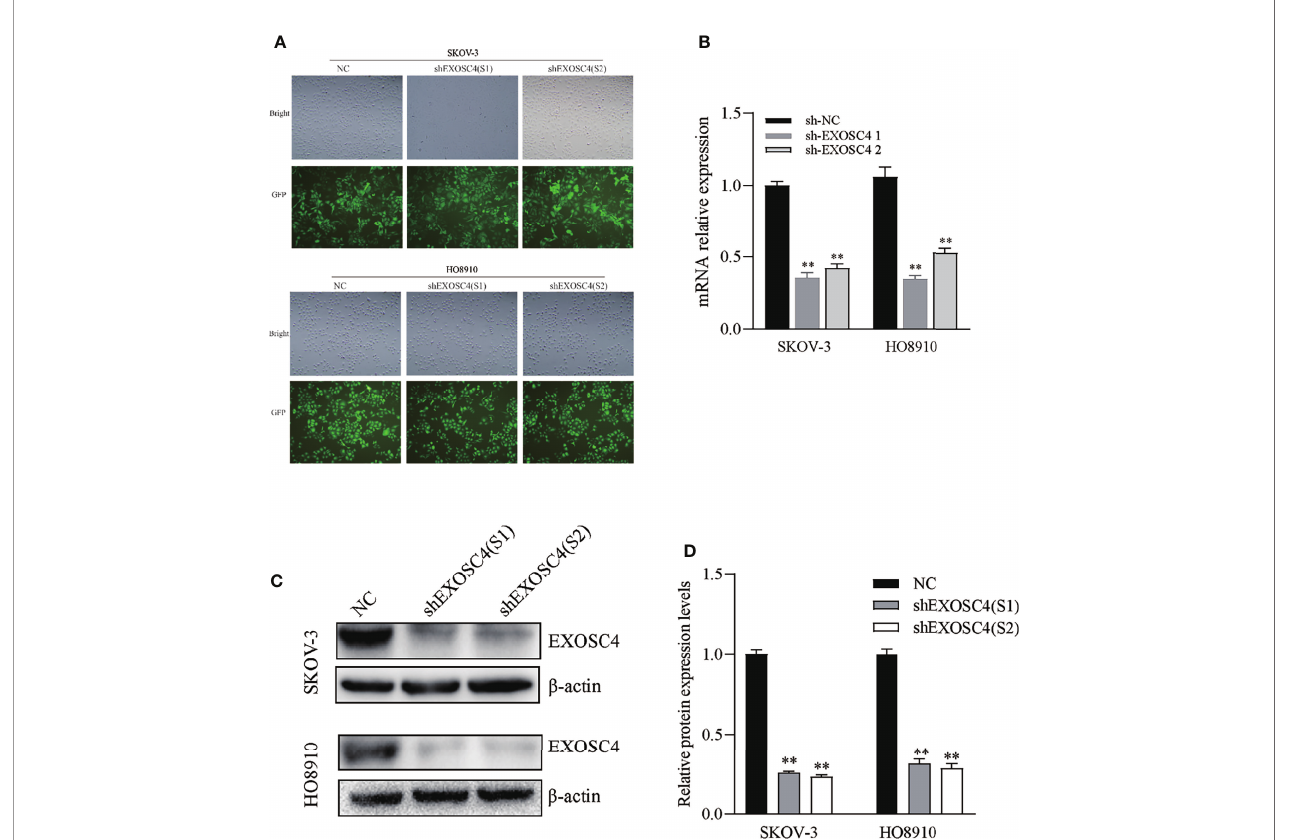
FIGURE 2 | Lv-shRNA mediated EXOSC4 silencing in SKOV-3 and HO8910 cell lines. (A) EXOSC4 (GFP) expression in SKOV-3 and HO8910 cells as detected by fl uorescence microscope (magni fi cation 100×). Infection ef fi ciency was > 90%. (B) Depletion of EXOSC4 mRNA in SKOV-3 and HO8910 cell lines treated with Lv- shEXOSC4 was determined by RT-PCR. (C) EXOSC4 protein in SKOV-3 and HO8910 cell lines was detected by western blot. (D) Analysis of EXOSC4 protein levels in SKOV-3 and HO8910 cell lines by Image J software analysis. **p <